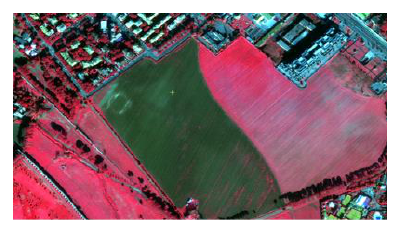
Figure 12. false colour composite on a cultivated field of